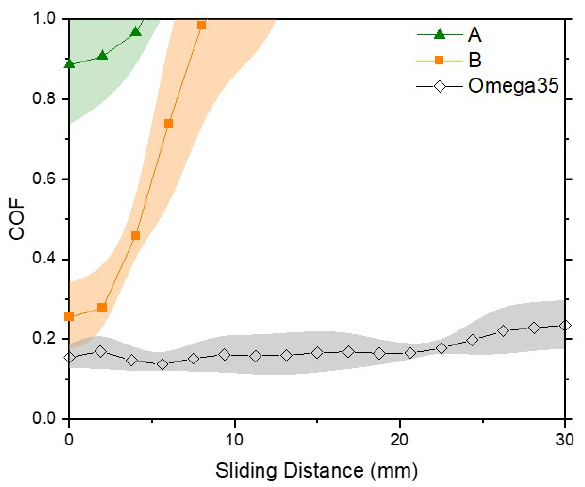
Figure 3. Friction evolutions for water-based lubricant and oil-based lubricant. The connected scatter lines represent the average coefficient of friction values while the shadows represent the standard